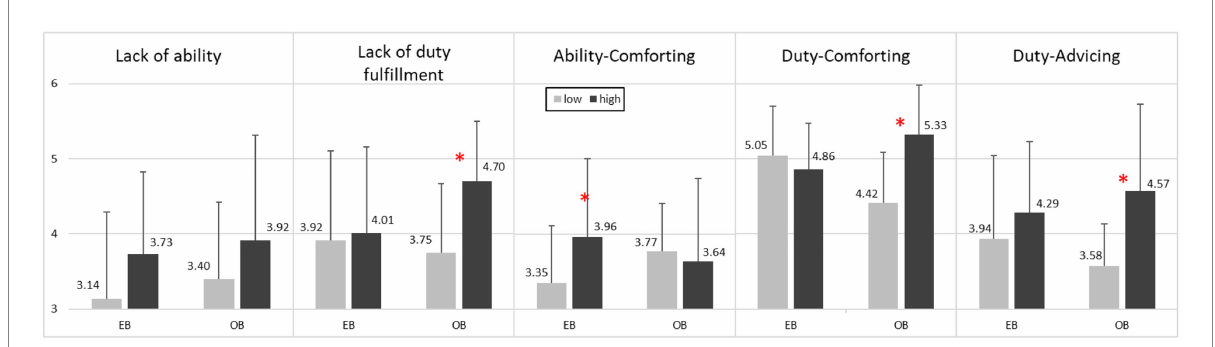
FIGURE 1 Mean scores of lack of ability, lack of duty fulfillment, ability-comforting, duty-comforting, and duty-advising feedback between low-and high- score groups in EB and OB. EB, Entity belief; OB, Obligation belief. Scores between low-and high-score of EB and OB groups were compared using two tailed t test. * p <